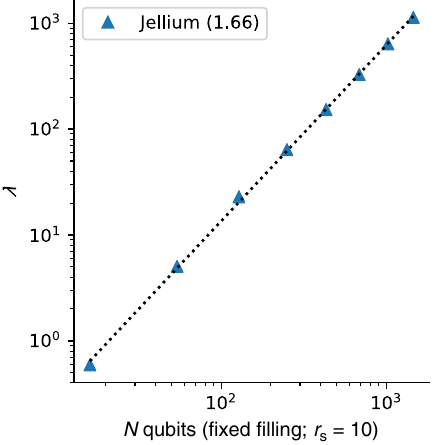
FIG. 17. The value λ as a function of the number of qubits N for the 3D spinful dual-basis jellium Hamiltonian at a Wigner-Seitz radius of 10 Bohr radii (assuming the system is initialized at half- filling so N ¼ d 2 η e ), which corresponds to an increasing cell volume as the number of basis functions increases. This density was chosen for study since it is in the classically challenging regime for jellium [39]. The bound is in atomic units of energy (Hartree). The number in parentheses corresponds to the best-fit exponent for the trend line (the dotted line), which suggests that λ ¼ O ð ∼ N 5 = 3 Þ .